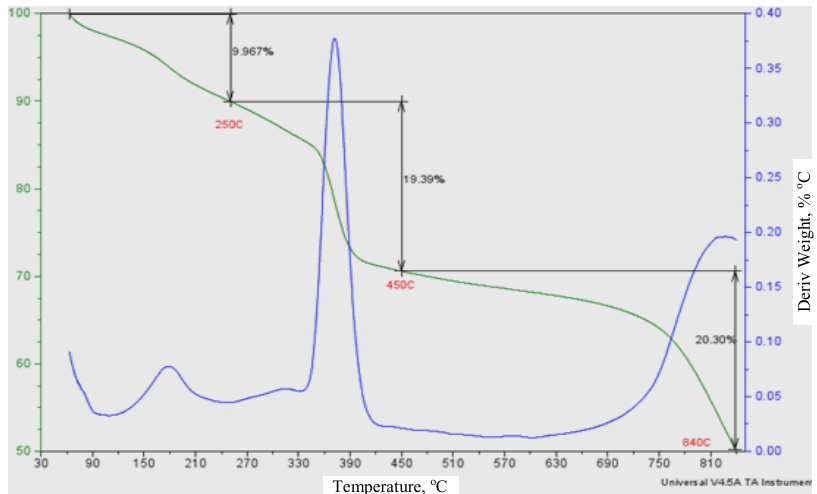
Figure 5. TG-DTG of PTSA doped tetraaniline nanorods prepared at a molar ratio of N- phenyl-1, 4-phenylenediamine to PTSA for